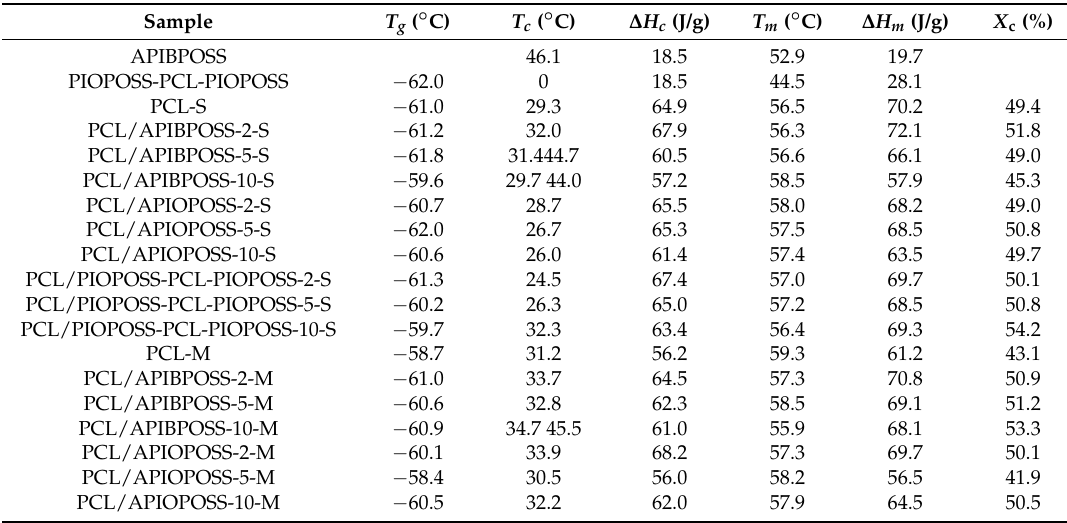
Table 1. DSC data for PCL and PCL/POSS